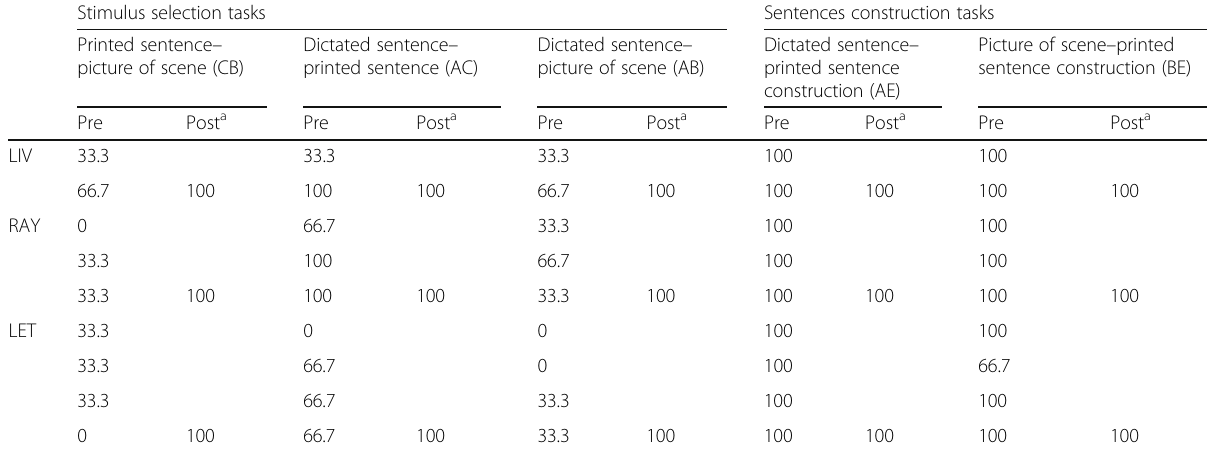
Table 2 Performance of participants in stimulus selection (CB, AC, and AB) and sentences construction (AE and BE) during the pretests and posttest probes for trained sentences Stimulus selection